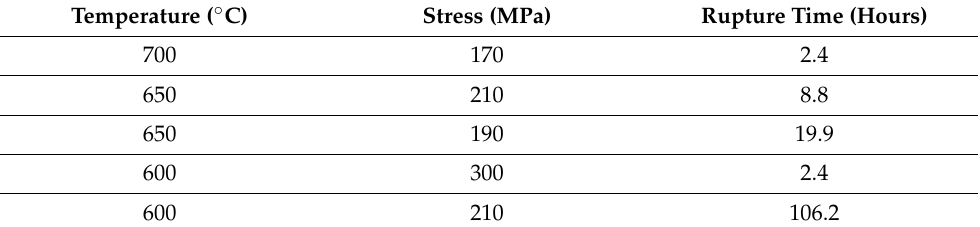
Table 4. Creep test conditions under constant temperature and stress, and the resulting creep rupture time for each test specimen.